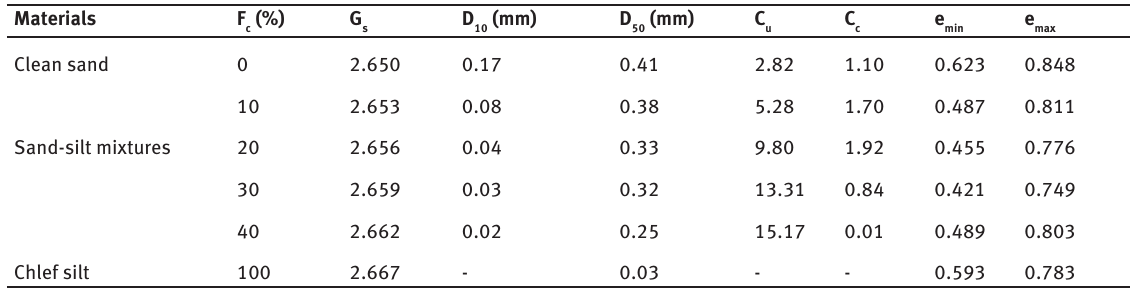
Table 1: Index properties of sand-silt mixtures.